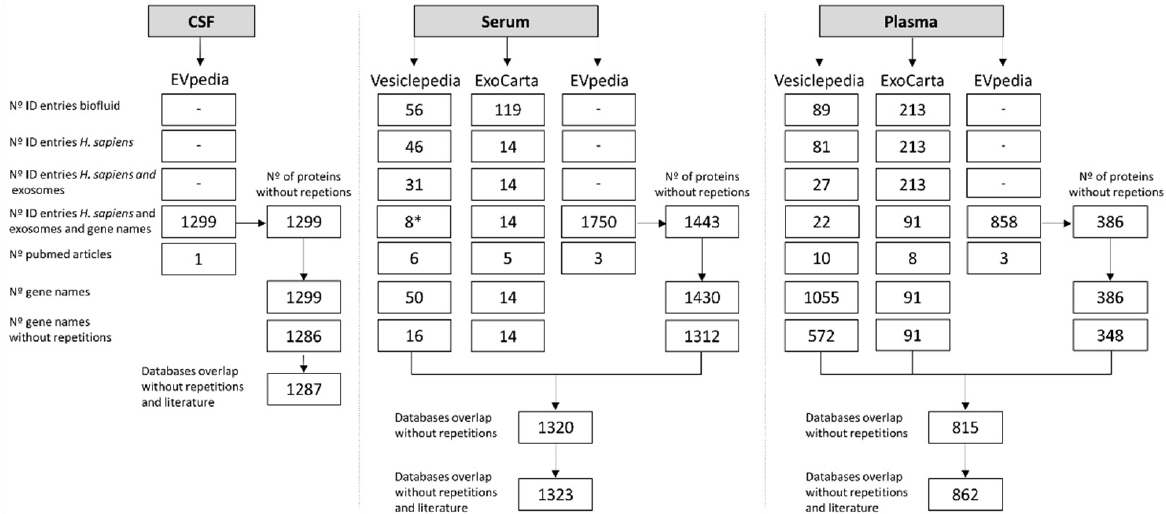
Figure 1. Exosomal proteomes obtained for the distinct biofluids. Steps implemented to obtain the final proteomes using the three databases (Vesiclepedia, ExoCarta, EVpedia) for cerebrospinal fluid (CSF), serum and plasma. A set of exclusion filters was used in this order: number of entries for the biofluid, number of ID entries for Homo sapiens , number of ID entries for H. sapiens and exosomes, number ID entries for H. sapiens and exosomal gene names, number of corresponding PubMed articles, number of gene names and number of gene names without repetitions. Subsequently, the lists obtained for the three databases were overlapped, the repetitions deleted and, the gene names corresponding to the exosomal proteins identified in the literature for CSF, serum or plasma were included in the final lists. The EVpedia’s obtained Uniprot IDs were converted to gene names. In the case of CSF, only EVpedia had information available. * One study was excluded since it was related to urine exosomal proteome and not to serum.